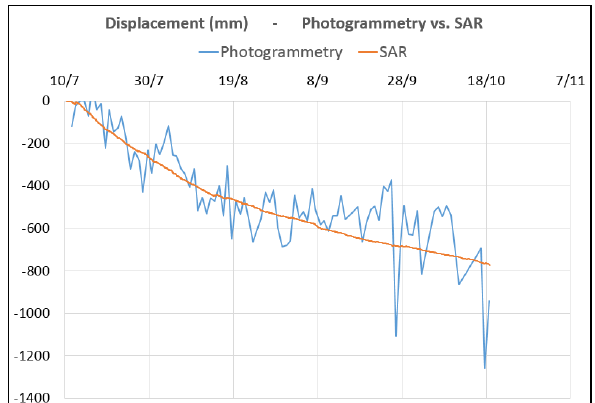
Figure 8: Photogrammetry vs. Ground Based SAR in one of the “virtual” measurement points on the